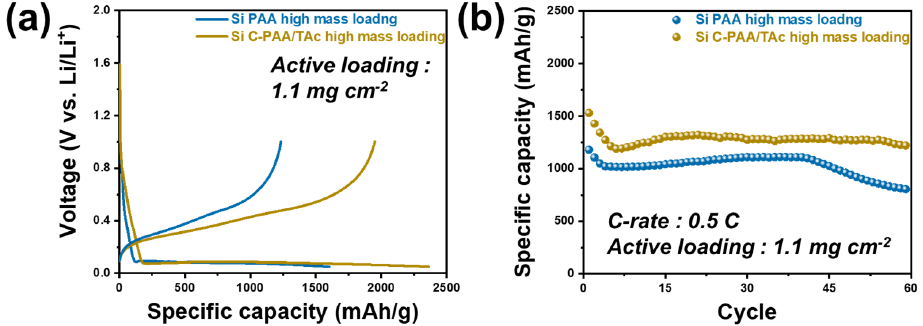
Figure 7. Electrochemical performance of Si ∥ Li half cells with high mass loading (~1.1 mg cm − 2 ): ( a ) galvanostatic charge/discharge profiles of half cells Si PAA and Si C-PAA/TAc (5:5); ( b ) cycling performance of Si PAA and Si C-PAA/TAc at 0.5 C.